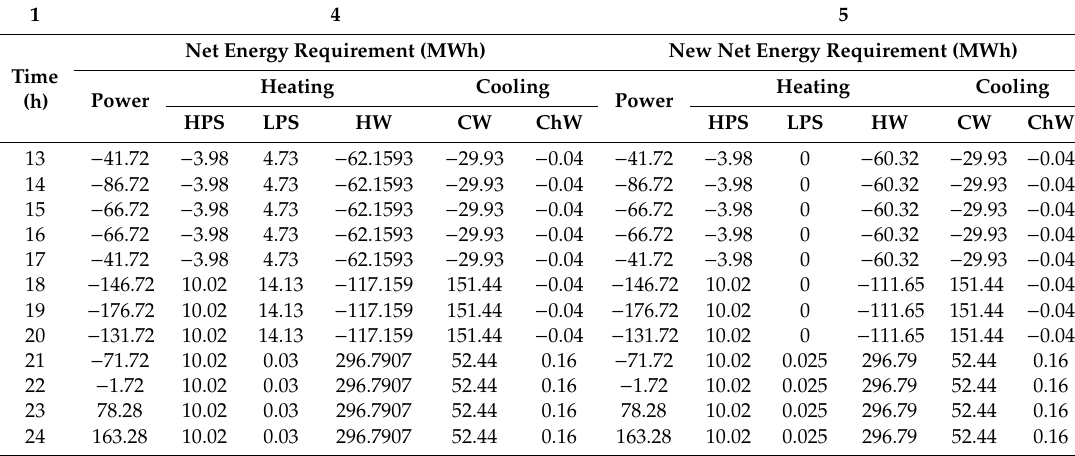
Table A12. TriGenSCA after iteration from time 13 to 24